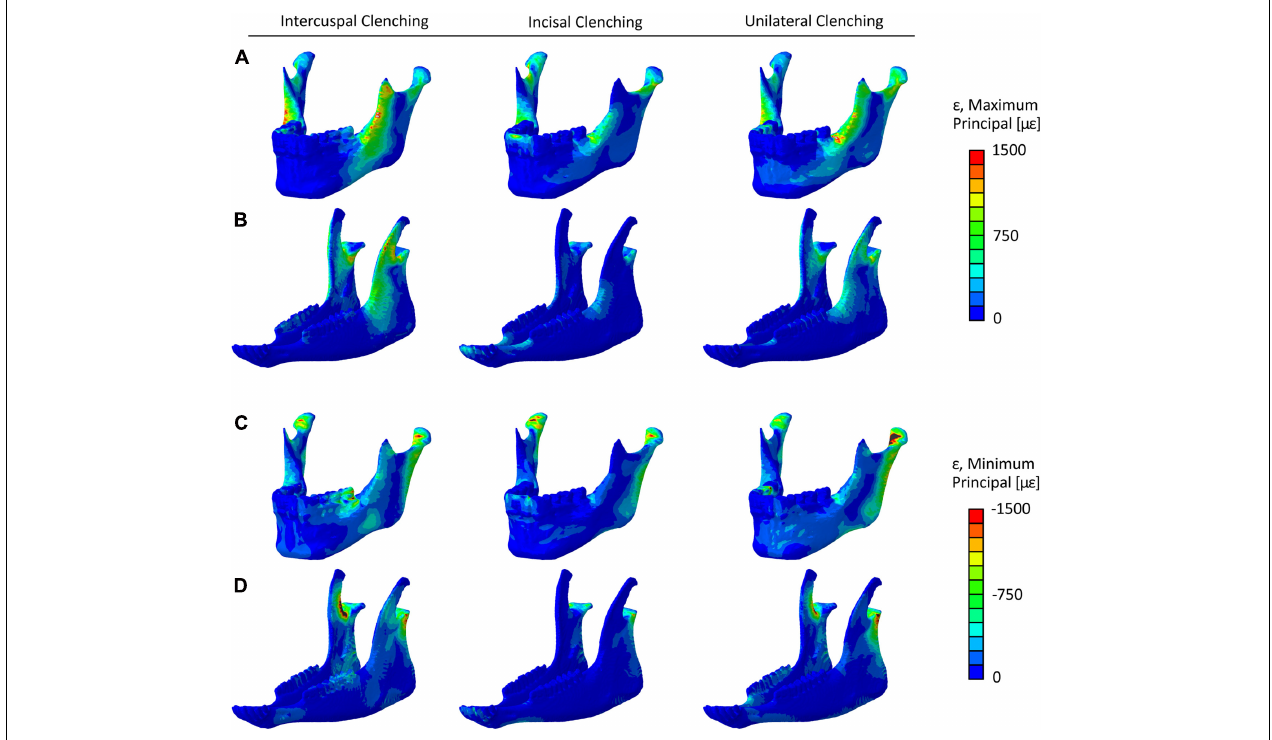
FIGURE 3 | Maximum principal strain ( ε ) distribution in the healthy (A) human and (B) sheep mandibles, and minimum principal strain distribution in the healthy (C) human and (D) sheep mandibles, for the intercuspal (ICP), incisal (INC), and unilateral (UNI) clenching tasks.